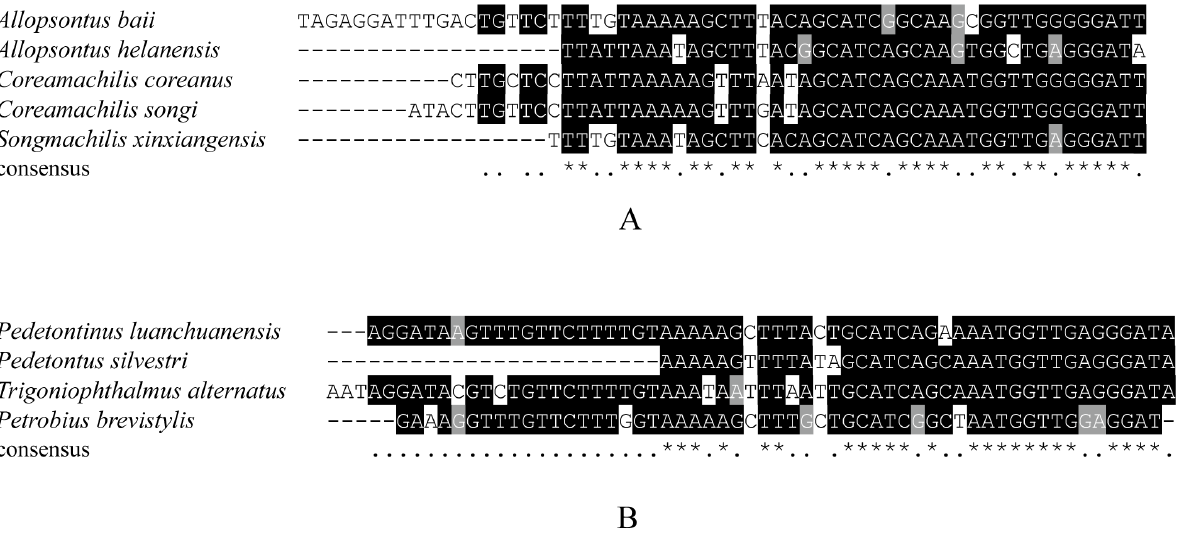
Figure 5. ( A ) Alignment of the stem among A. baii, A. helanensis, C. coreanus, C. songi and S. xinxiangensis . ( B ) Alignment of the stem among P. luanchuanensis, P. silvestri, T. alternatus and P. brevistylis .